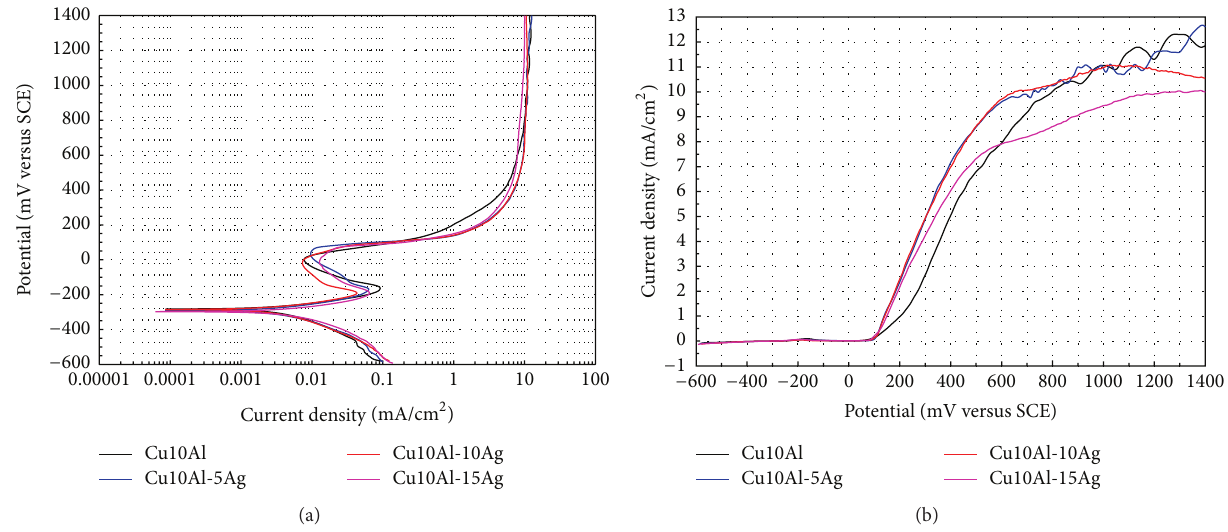
Figure 1: Polarization curves for the Cu10Al- 𝑥 Ag ( 𝑥 = 0, 5, 10, and 15) alloys in artificial saliva at 37 ∘ C (d 𝐸 /d 𝑡 = 1.0 mV/s); (a) 𝐸 versus log 𝑖 , (b) 𝑖 versus 𝐸 .